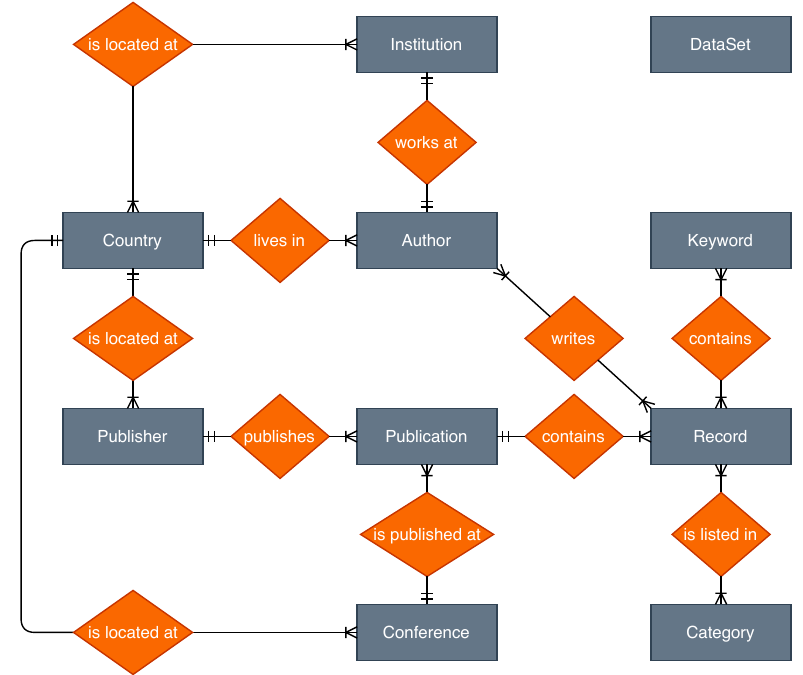
Figure 13. System data model: bibliographic